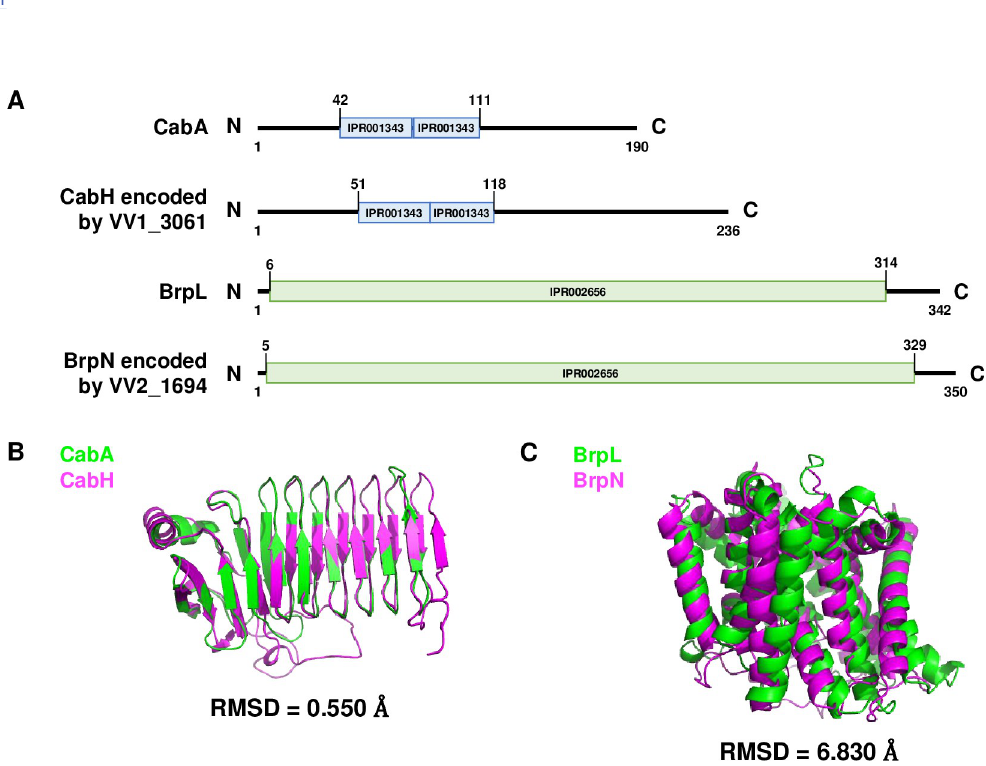
Fig 4. Predicted protein domains and structures of CabA, CabH, BrpL, and BrpN. (A) Protein repeats and domains of CabA, CabH, BrpL, and BrpN predicted by using InterPro. The numerical values represent the amino acid numbers of each